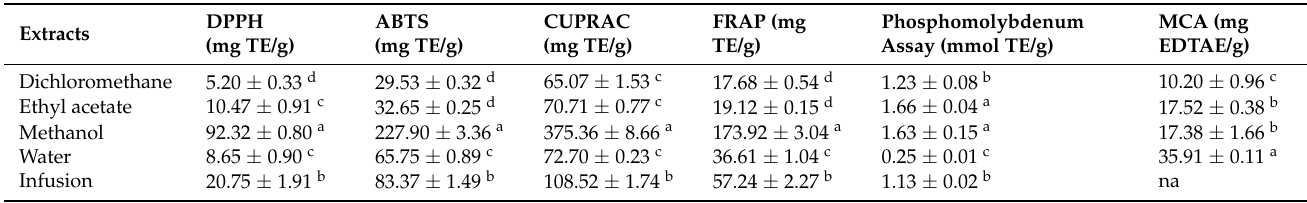
Table 2. Antioxidant properties of the tested extracts